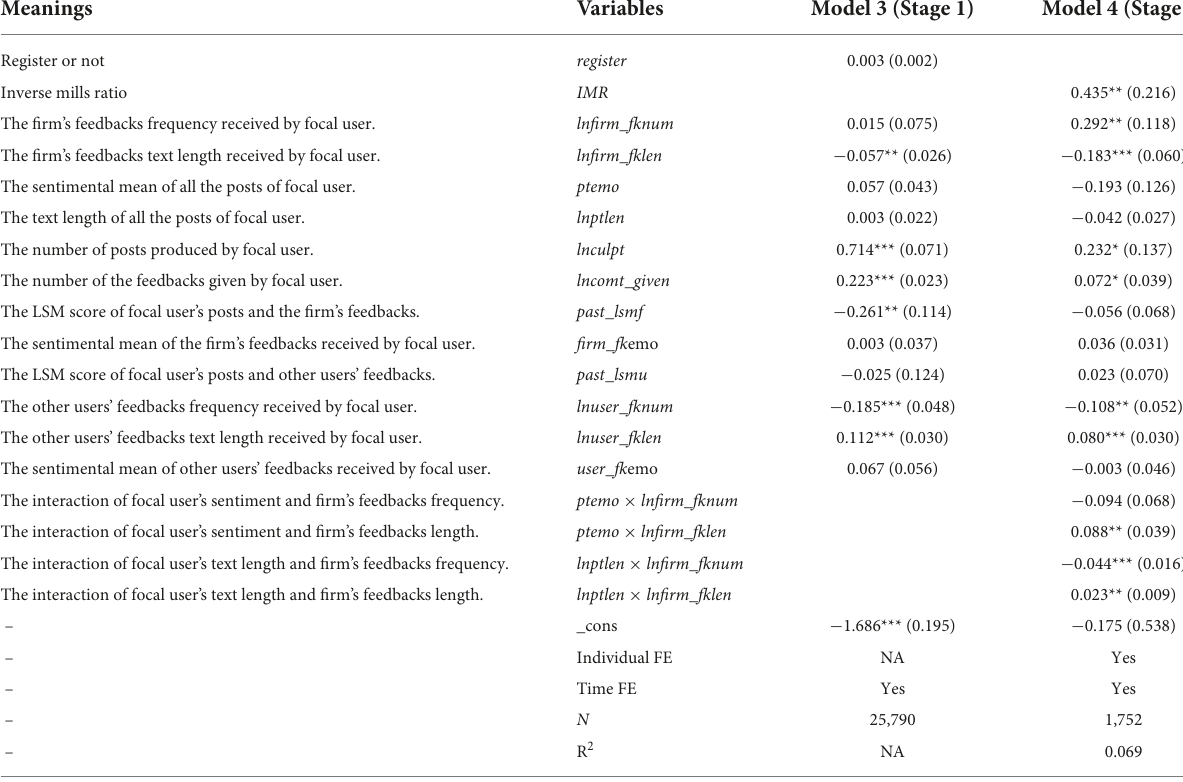
TABLE 3 Regression results after controlling for self-selection